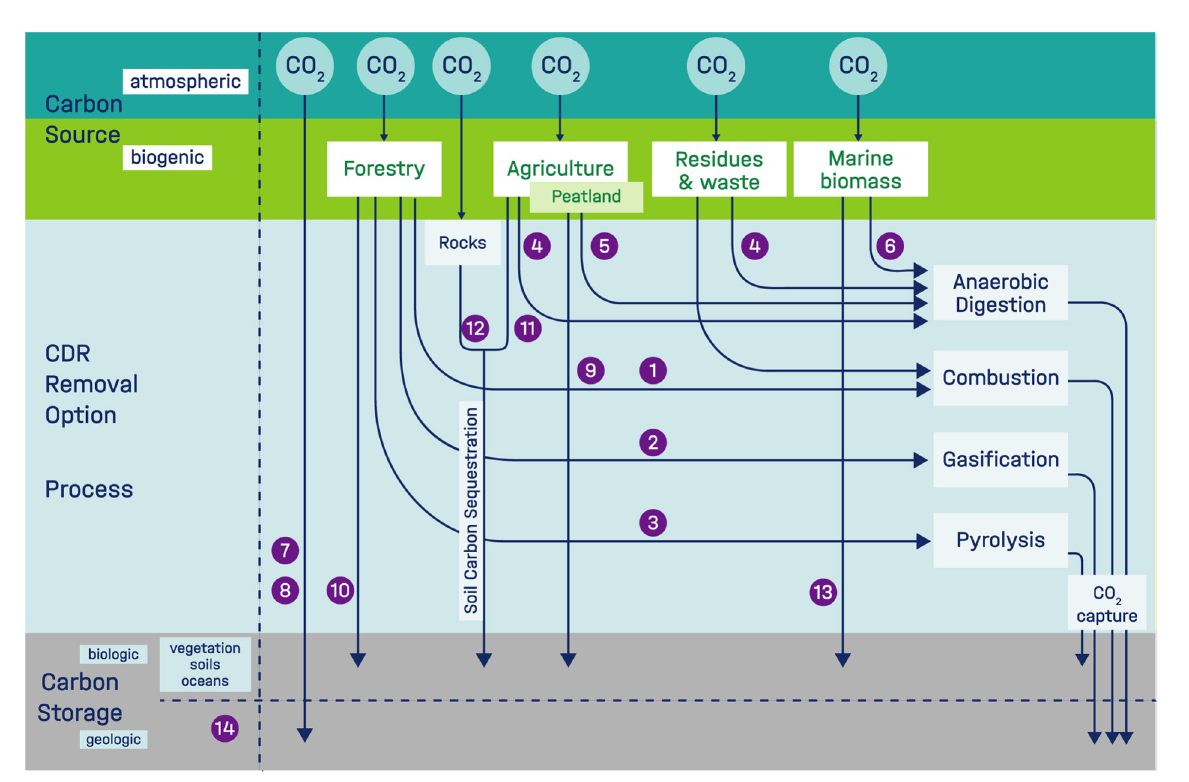
FIGURE1 Overview of the selected CDR options. Circled numbers correspond to the numbering of CDR concepts in the paper and represent following options: 1–BECC: biomass combustion CHP; 2–BECC: biogas CHP; 3–BECC: paludiculture for biogas CHP; 4–BECC: macroalgae for biogas CHP; 5–BECC: pyrolysis for biocoal production; 6–BECC: gasification for biofuels production; 7–DACC: centralized; 8–DACC: decentralized; 9–NSE: peatland rewetting; 10–NSE: afforestation of cropland; 11–NSE: SOC, cover crops; 12–NSE: SOC, ERW; 13–NSE: seagrass meadows Baltic Sea; 14–geological storage solutions (source: UFZ/Malgorzata Borchers, Helmholtz Climate Initiative // Julia Blenn, Creative Commons CC-BY NC 4.0